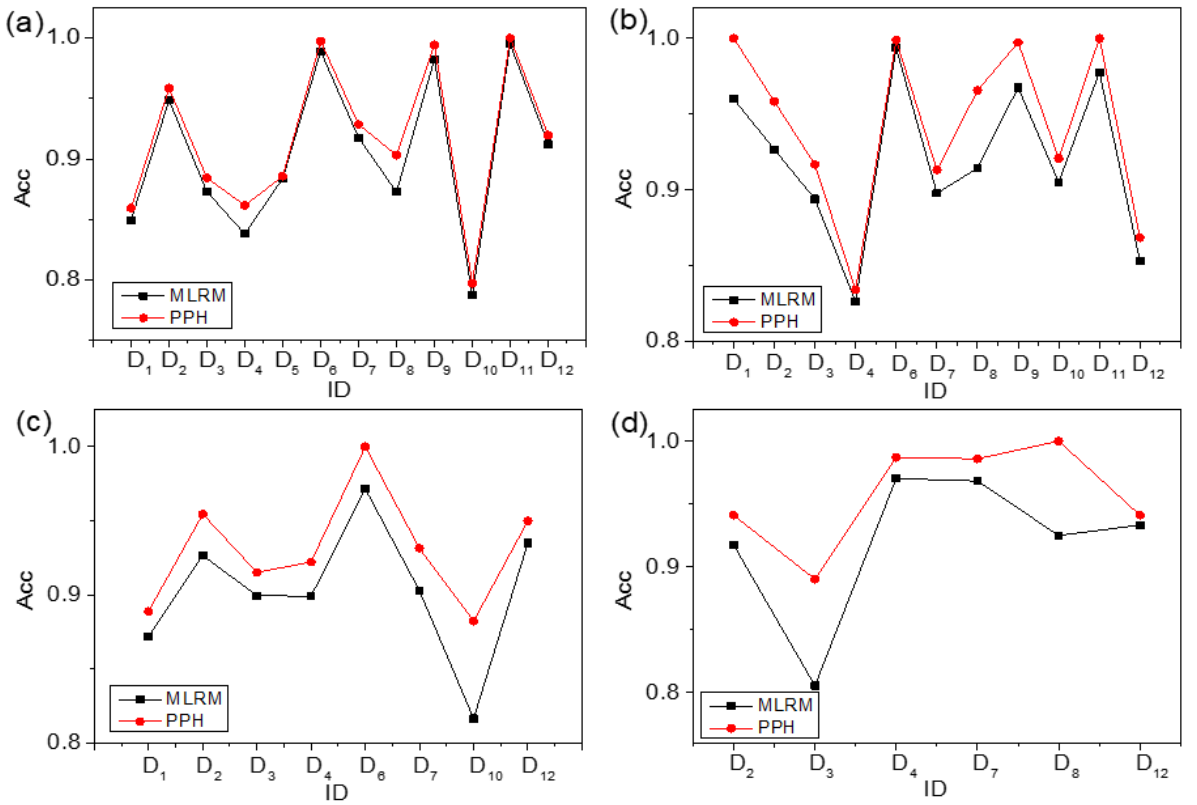
Figure 11. Accuracy comparison between PPH and MLRM. ( a ) all, ( b ) quinaries, ( c ) senaries, and ( d ) septenaries. Table 15. Accuracy comparison between PPH and MLRM in all, quinaries, senaries, and